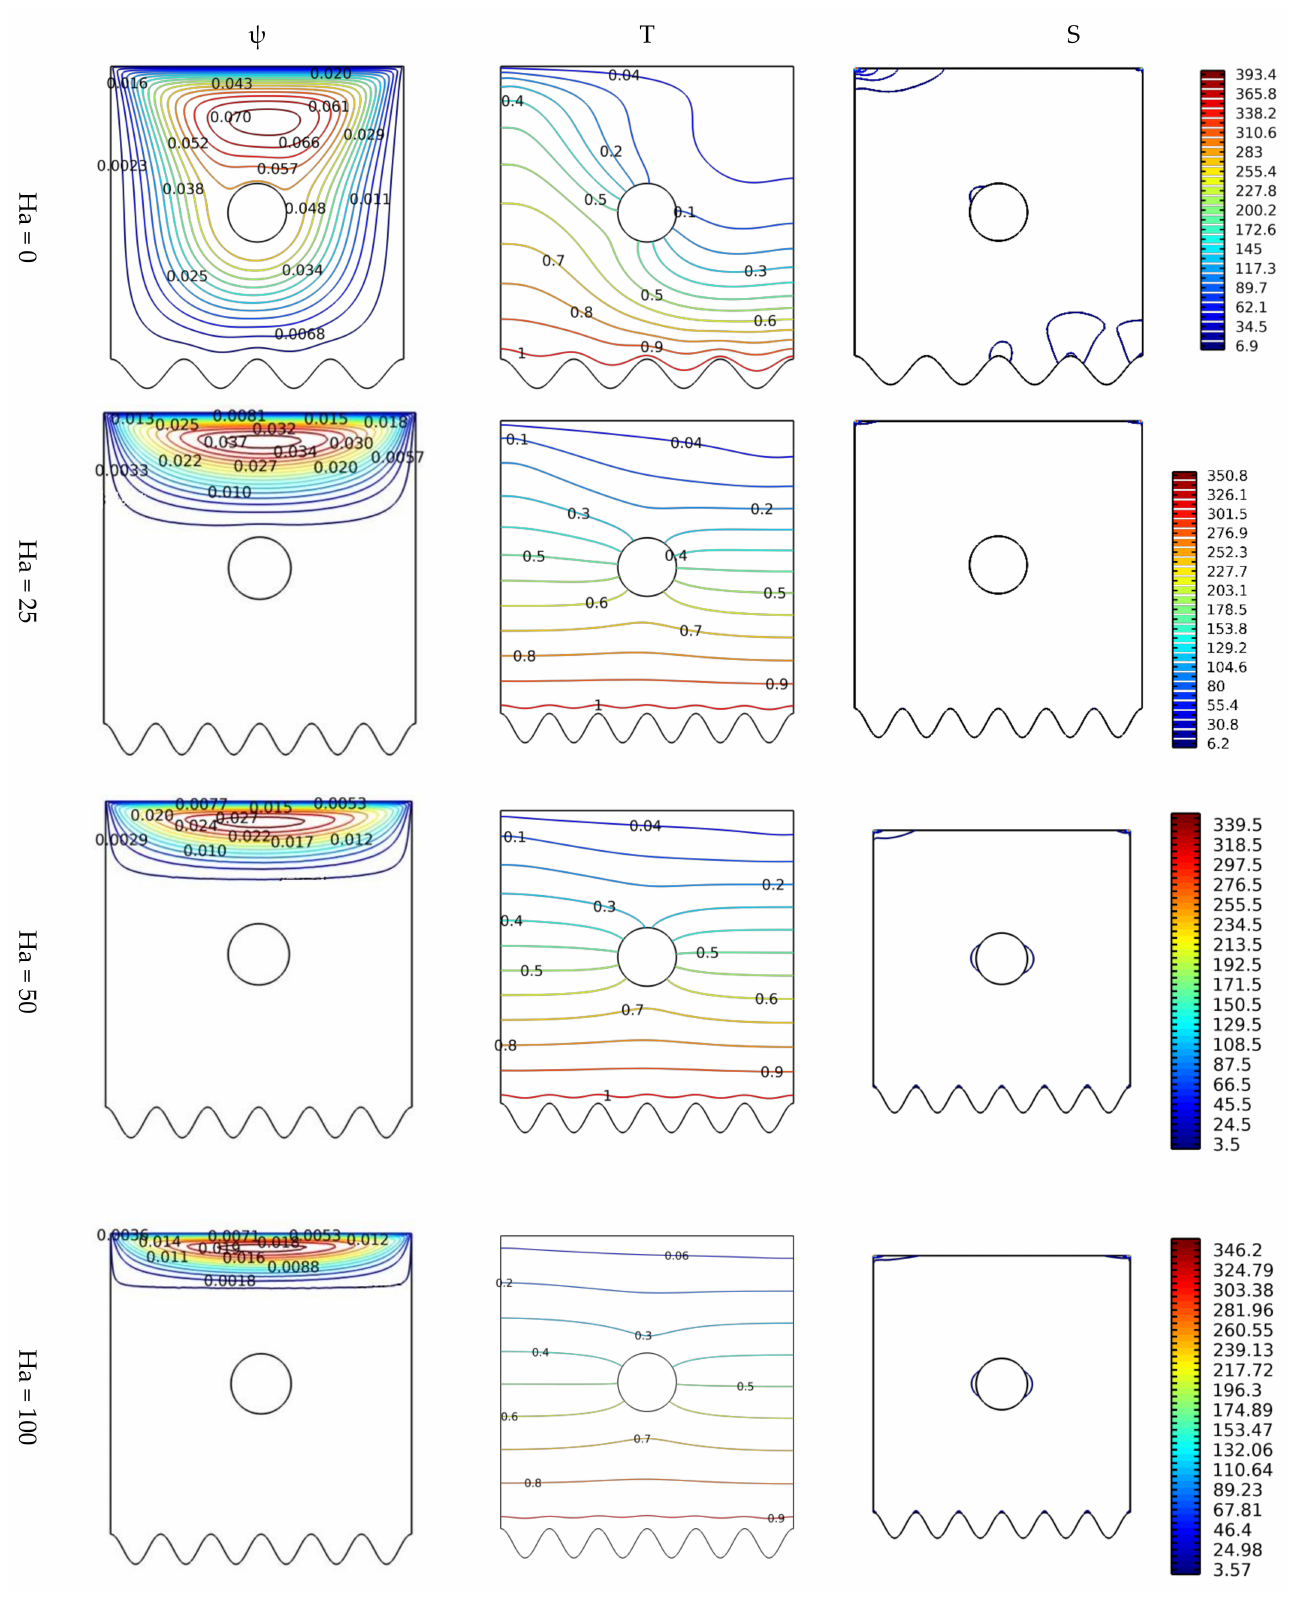
Figure 5. Distribution of streamlines, isotherms, and isentropic contours for various Hartmann numbers Ha at Gr = 10 3 , N = 8, and Da = 10 − 2